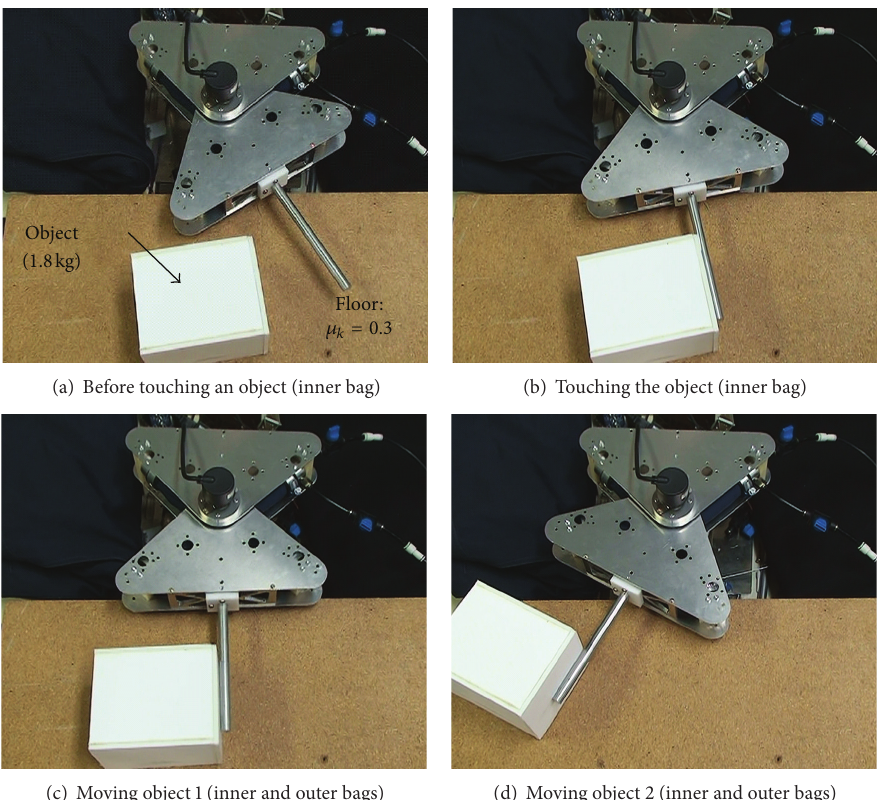
Figure 11: Motion of prototype joint before and after touching an object.